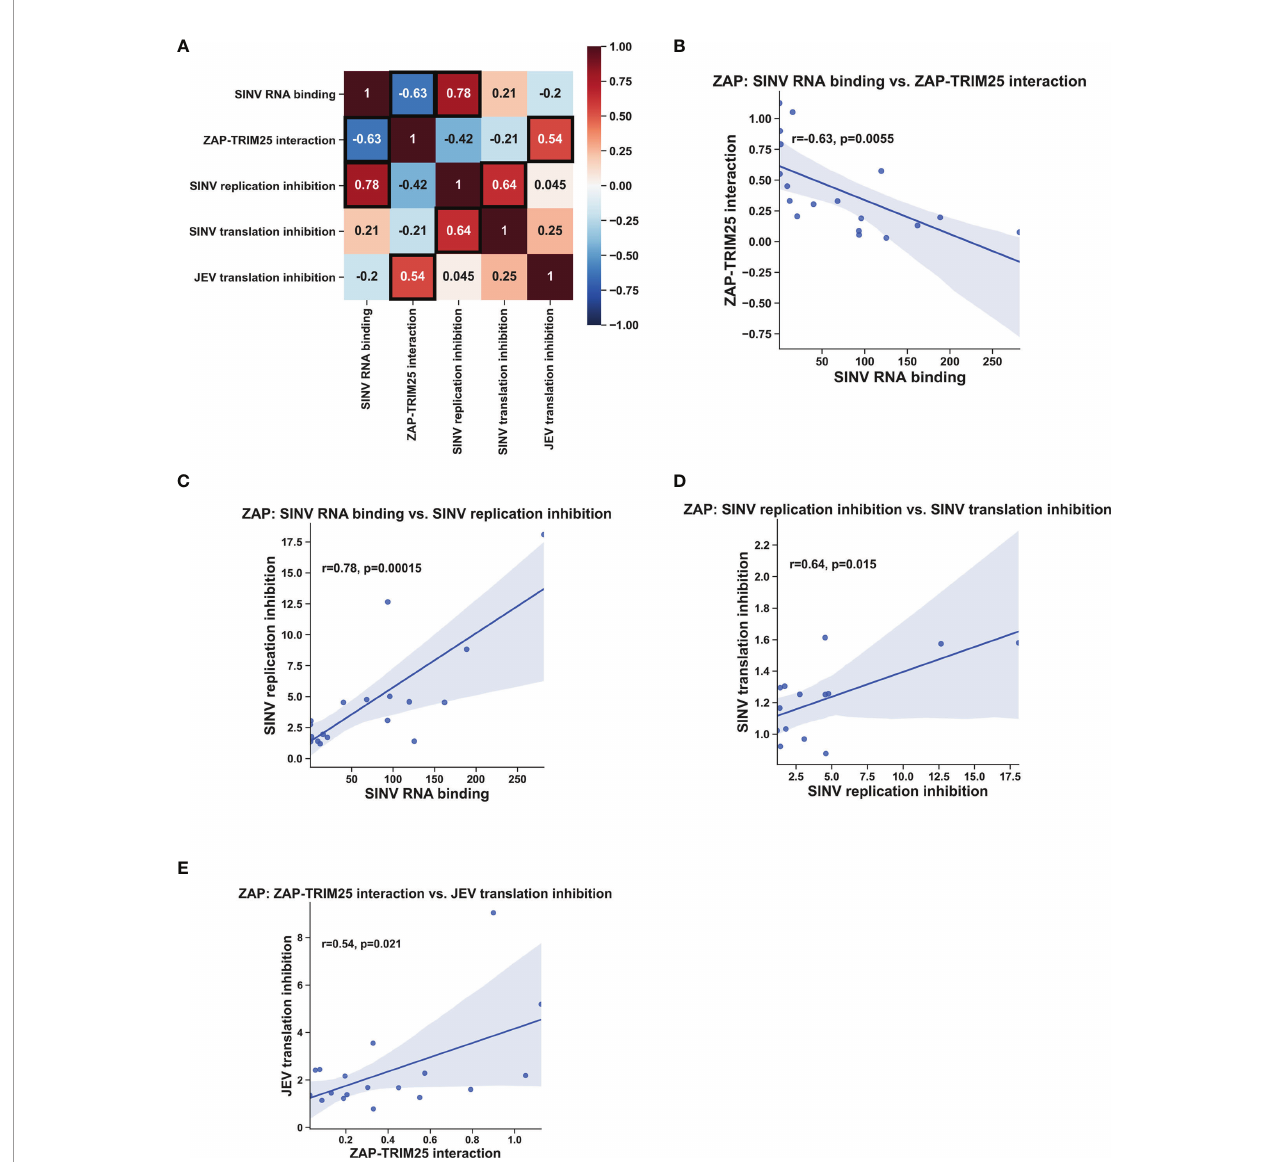
FIGURE 6 | Correlation analysis of ZAP RNA binding mutant phenotypes. Pearson correlation coef fi cients (r) and p-values (p) were calculated using the SciPy package in Python and plotted using the Matplotlib and Seaborn packages. Pearson correlation coef fi cients are summarized in a heat map (A) . Boxed coef fi cients have statistically signi fi cant p-values (p < 0.05). Pairwise correlations with signi fi cant p-values from (A) are shown in (B – E)